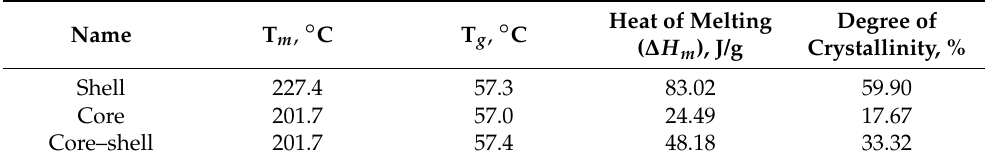
Table 2. Degree of crystallinity and melting temperature of core–shell (PVA-PEG-SiO 2 @PVA-GO), core (PVA-PEG-SiO 2 ), and shell (PVA-GO) fibers.